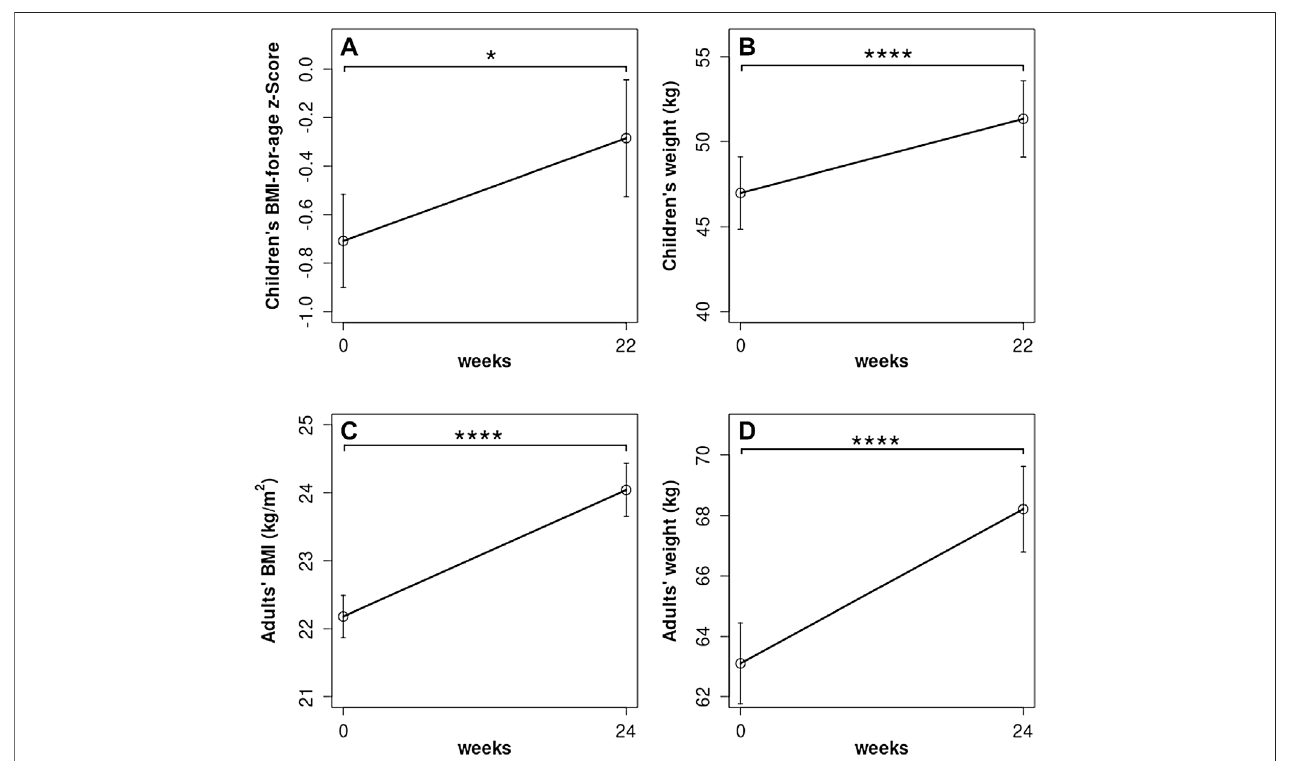
FIGURE 4 | (A) Estimated marginal means (EMM) for children ( n = 26) BMI-for-age z-scores and (B) weight during the ETI therapy. (C) Adult ’ s EMM BMI and (D) weight. p : p < 0.05, pppp : p < 0.0001.